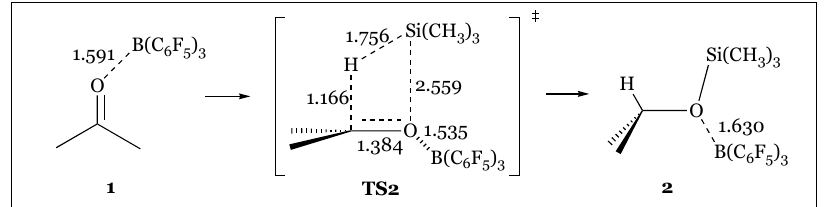
Figure 40. Intermediates and transition states of the carbonyl-activation reduction mechanism.